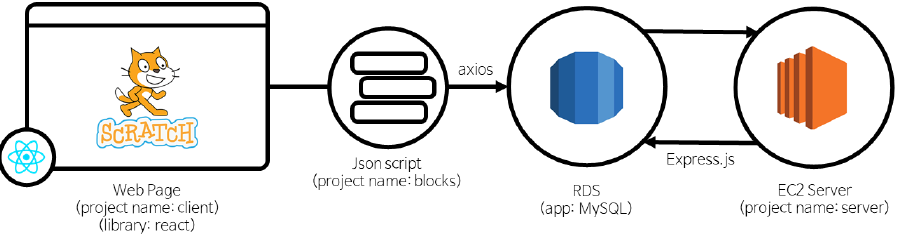
Figure 1. Data flow diagram of a programming log crawler.